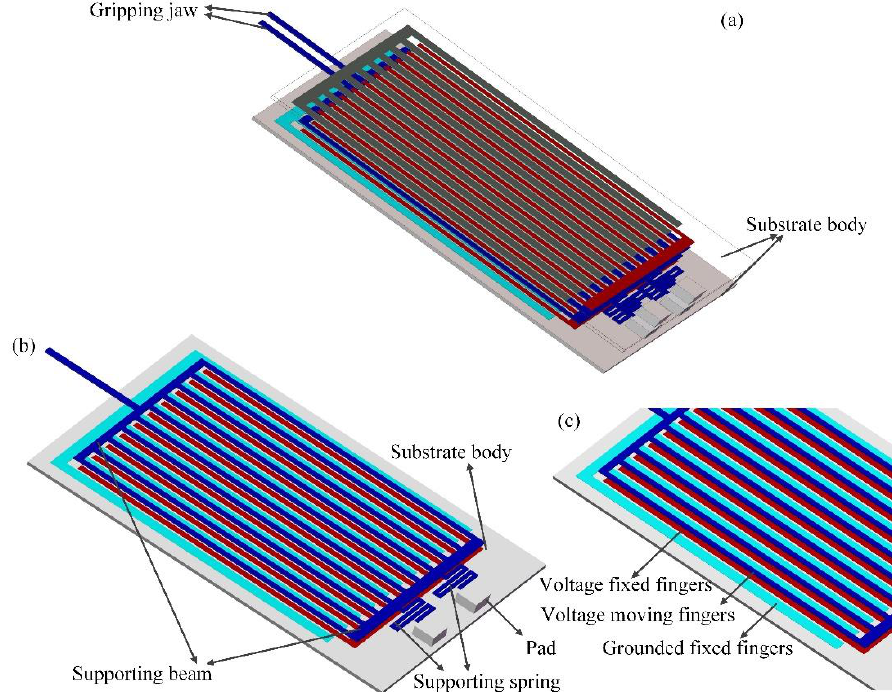
Figure 10. Schematic detailed view of the microgripper. ( a ) Structural diagram of the whole de- vice; ( b ) top view of one microgripper arm; ( c ) closer view of the electrostatic repulsive actuator configuration.